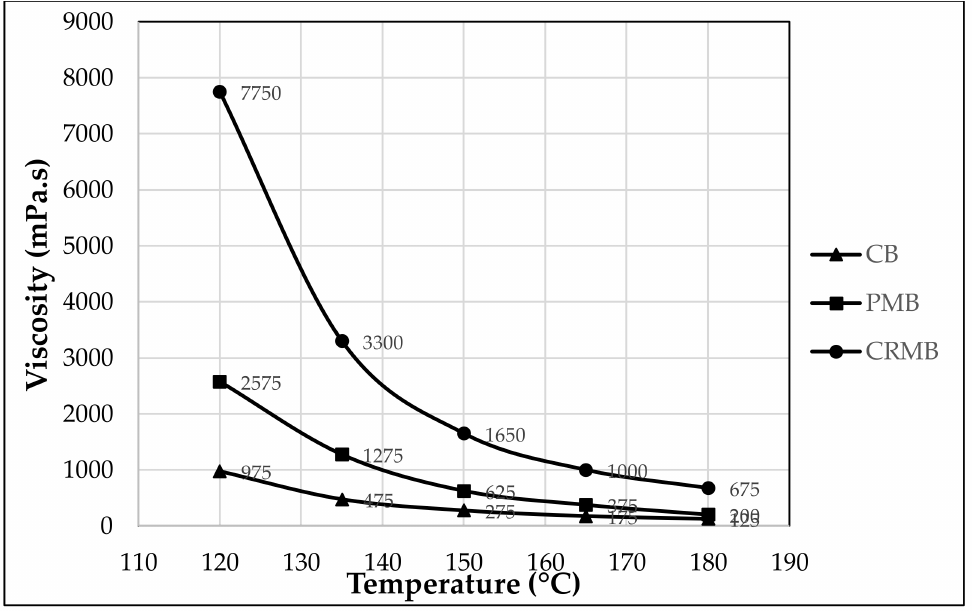
Figure 4. Viscosity test